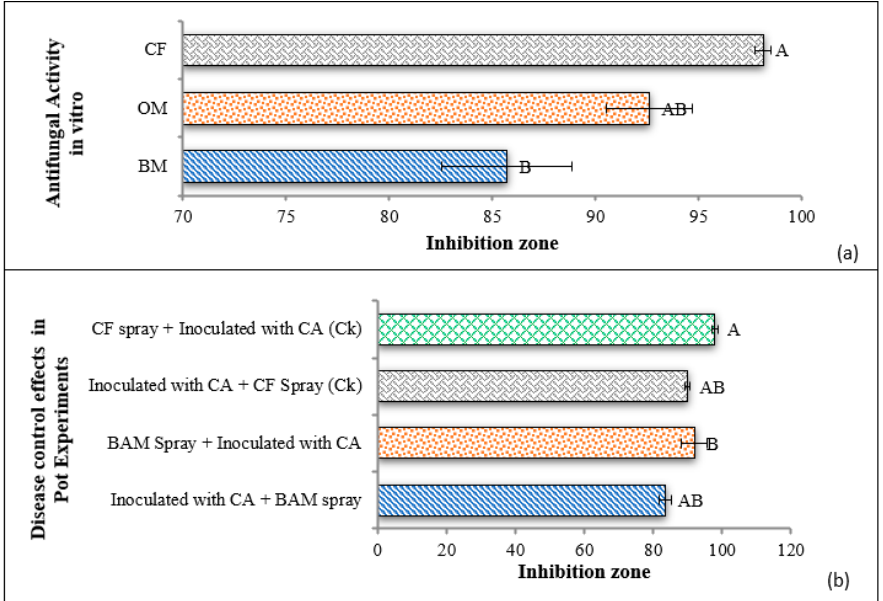
Figure 5. Antagonistic activity of BAM strain in vitro study. ( a ) CF (commercial fungicide) control was a control value. OM (optimized fermentation medium broth), BM (basic medium broth). ( b ) Disease control effects in pot experiments. CF = commercial fungicide, CA = Cercospora arachidichola.